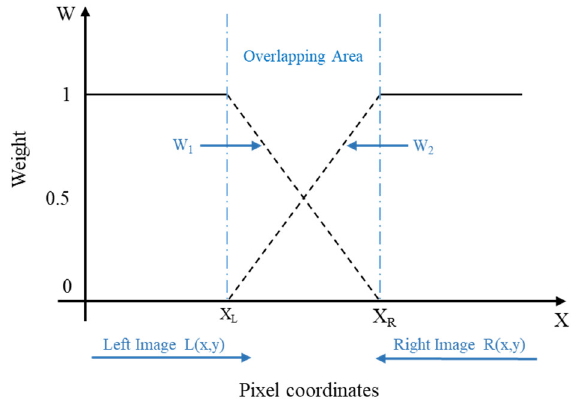
Figure 3. Diagram of the fade-in and fade-out weighted average fusion method.